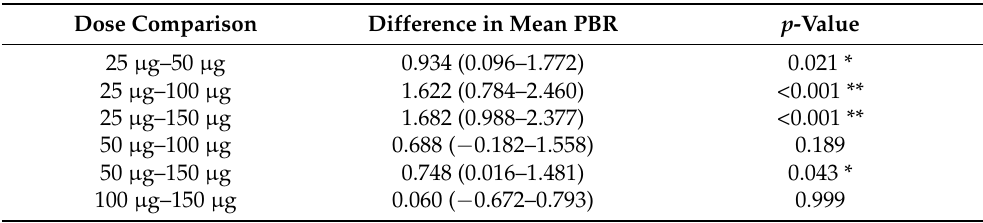
Table 1. ANOVA with Tukey HSD (honestly significant difference) comparing the difference of mean PBR among the four treatment doses.